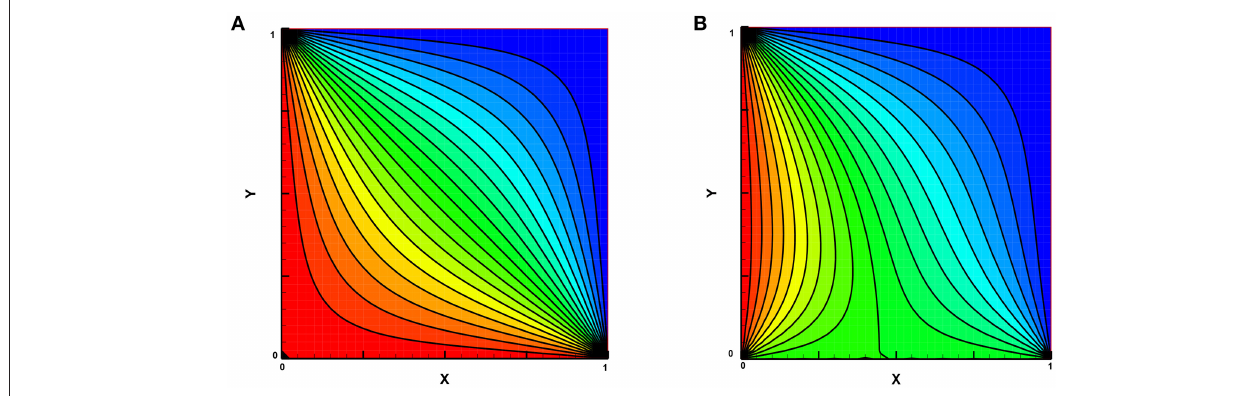
FIGURE 4 | MRF pressure distribution in two directions. (A) Pressure distribution line( k p = 1). (B) Pressure distribution line ( k p =